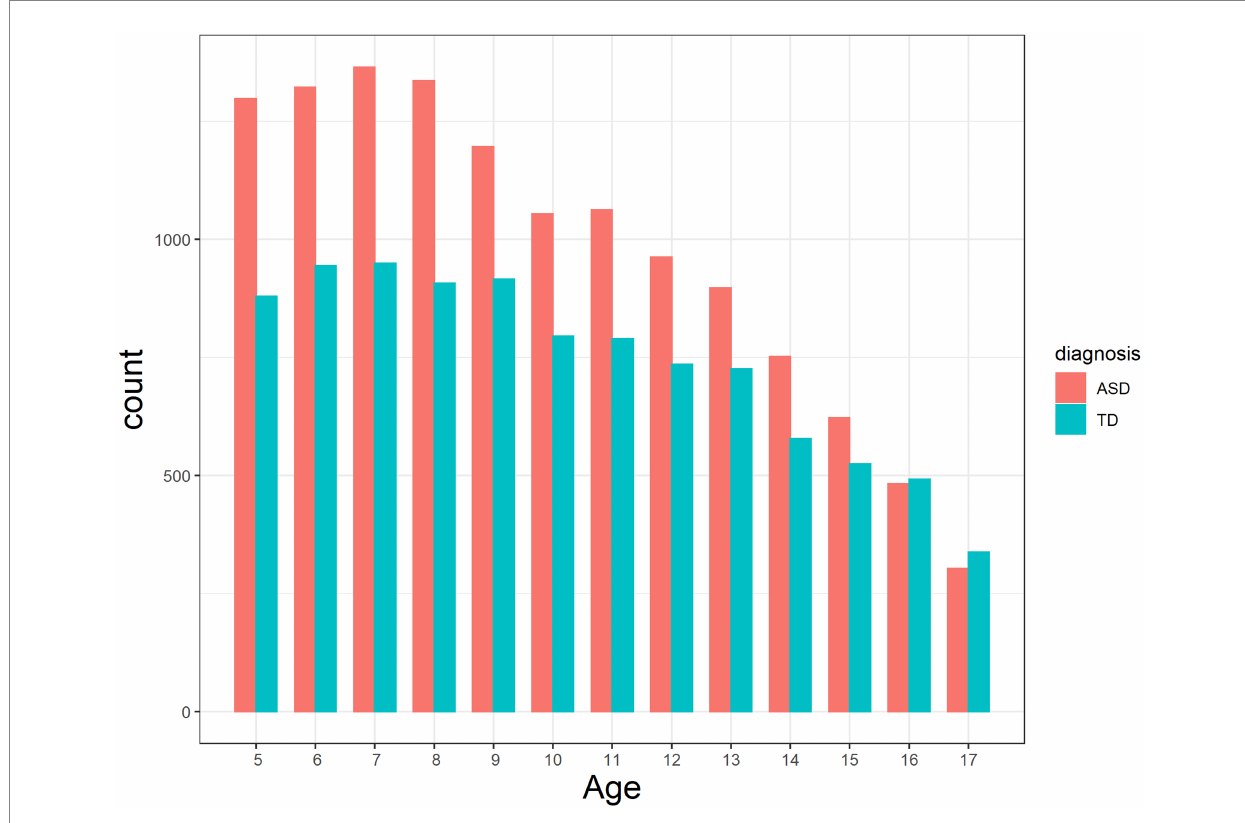
FIGURE 1 Age distribution by group (“TD” = Sibs